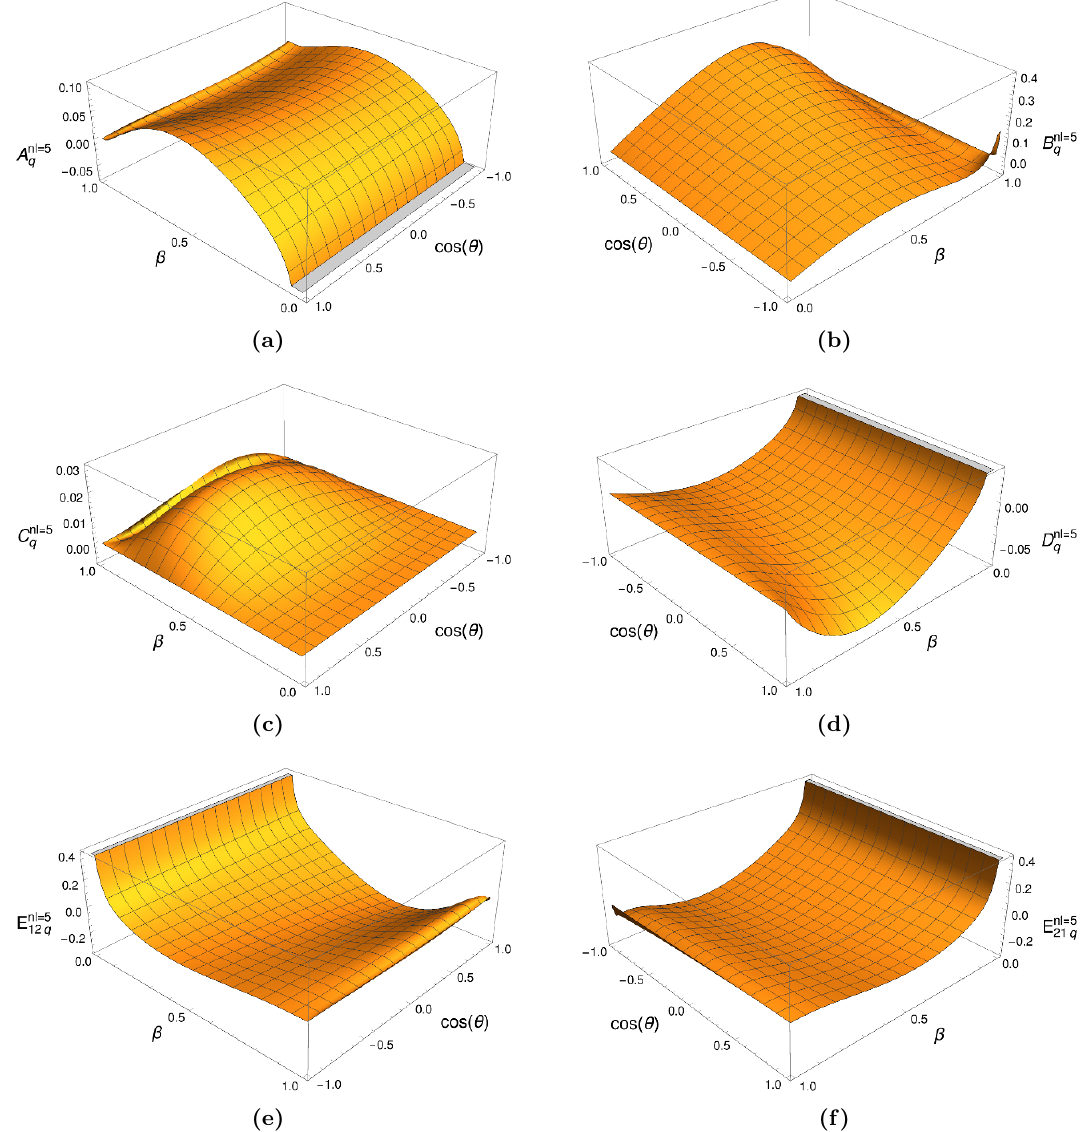
Figure 3 . Finite remainder coe(cid:14)cient functions of the spin-density matrix in case of initial state quarks for n = l